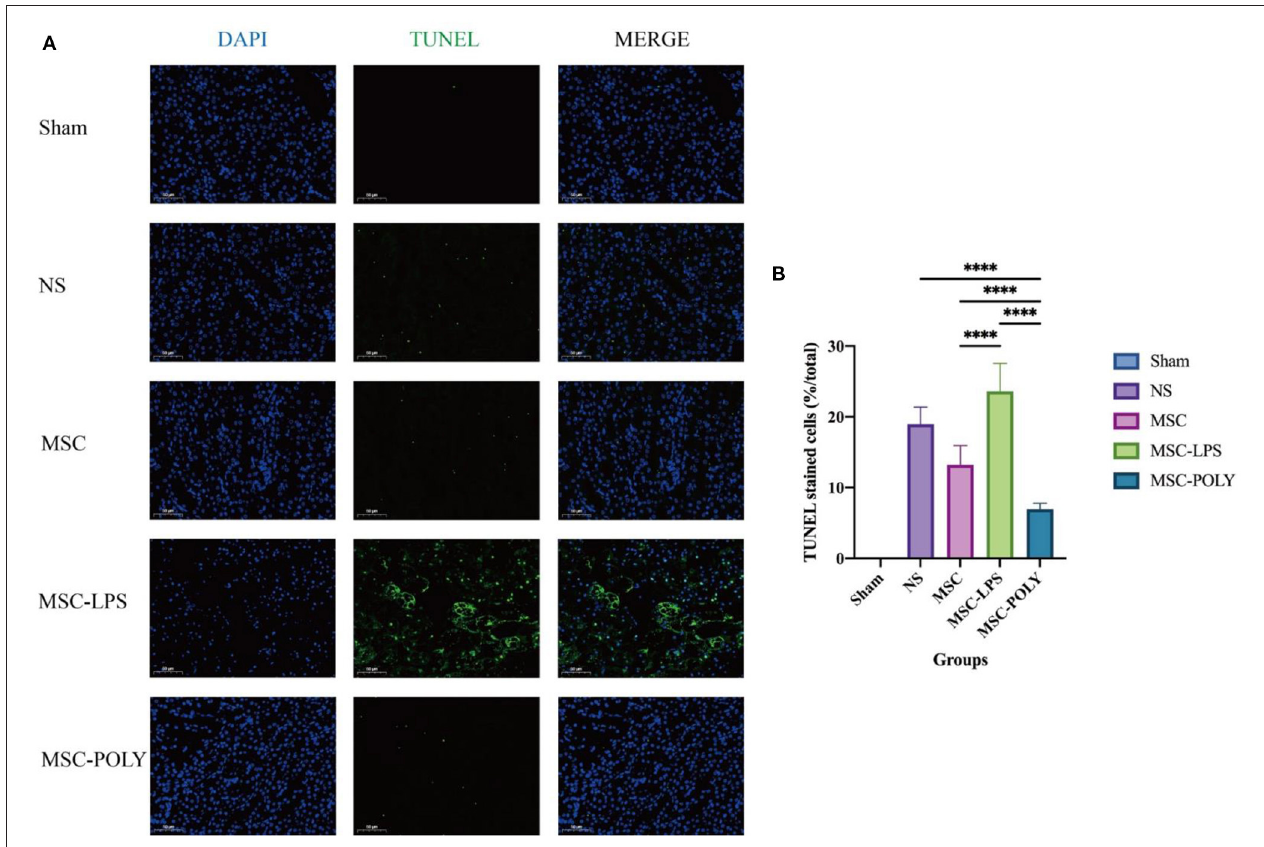
FIGURE 3 | Apoptotic levels of renal tubular epithelial cells in mice treated for 72 h. (A) Apoptosis pictures detected by TUNEL assay (200 × ) at 72h of five groups. (B) Proportion of TUNEL staining positive cells (i.e., apoptotic mouse renal tubular epithelial cells) at 72h of five groups. Values were expressed as mean ± standard deviation (mean ± SD), n = 6, **** P <